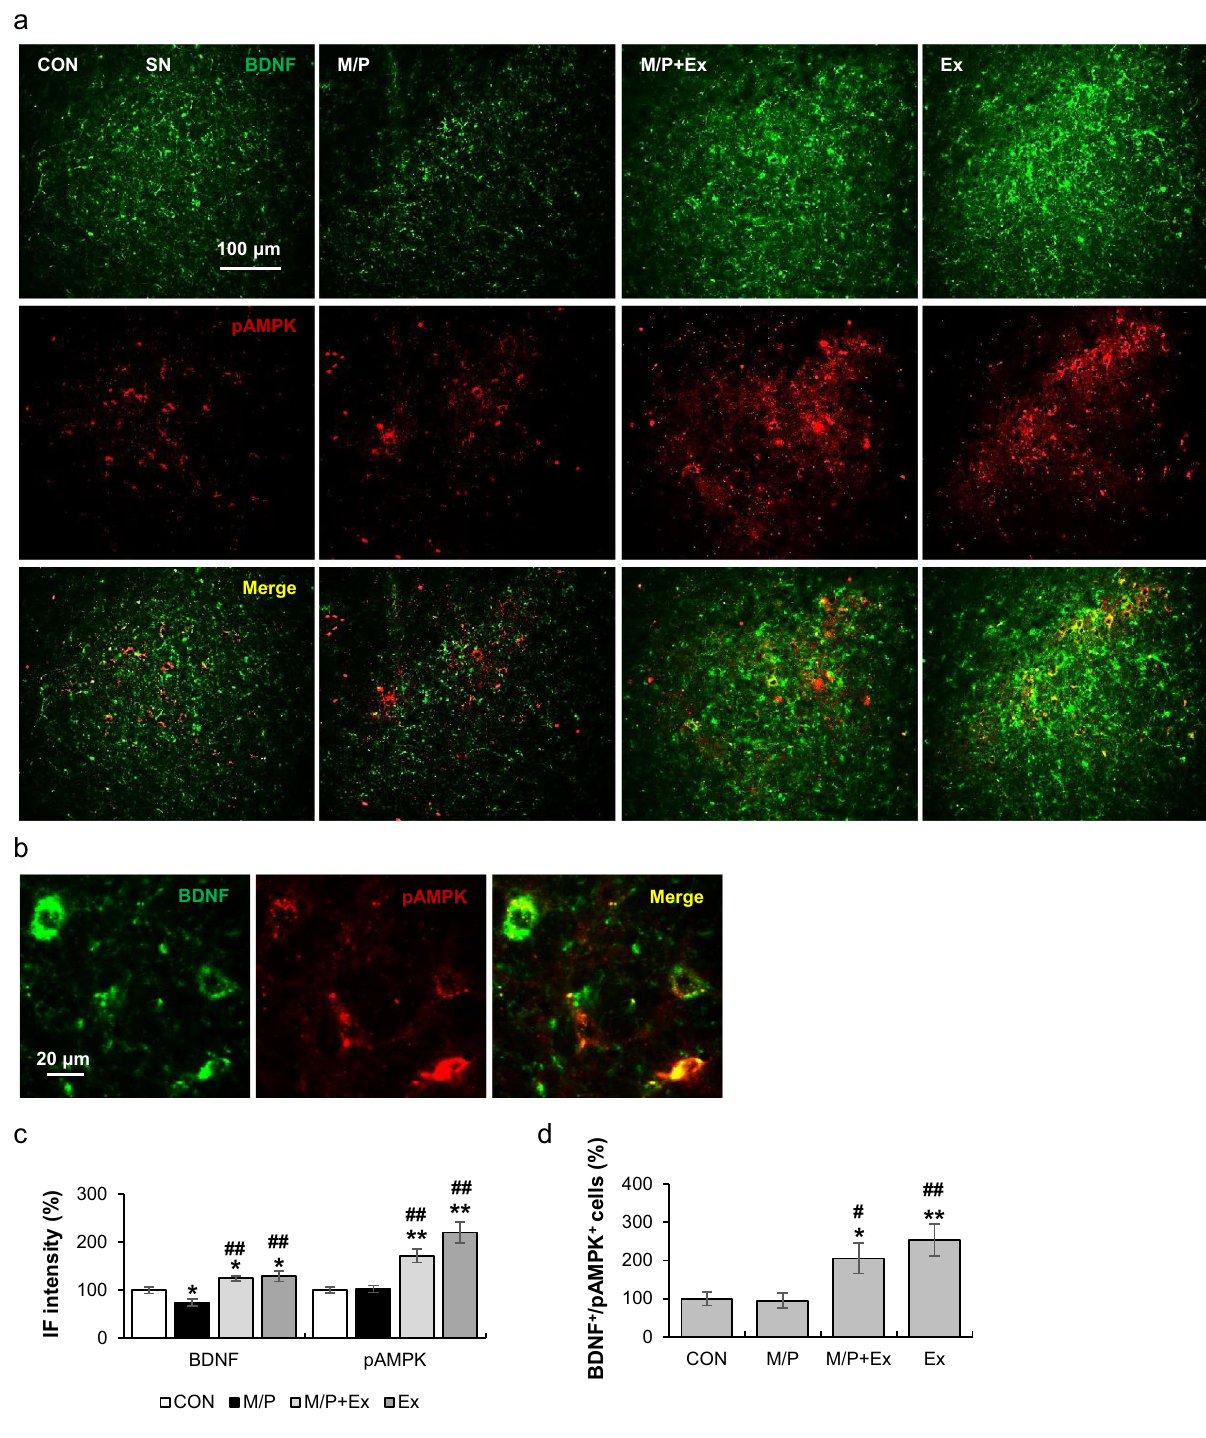
Figure 7. Rotarod walking exercise activated the AMPK/BDNF pathway in the SN area of M/P-treated mice. ( a ) Photomicrographs of the double fluorescent staining of SN BDNF + and pAMPK + cells (N = 8 in each group, 200 × of magnification). ( b ) Representative photomicrograph of the high magnitude of BDNF + /pAMPK + cells (400 × of magnification). ( c ) Quantification of the fluorescent intensity of SN BDNF + and pAMPK + cells showing that exercise restored the M/P-induced decrease in BDNF + cells, and enhanced the pAMPK + IF intensity, regardless of M/P treatment. ( d ) Quantification of the fluorescent staining of SN BDNF + /pAMPK + cells showing that exercise increased the number of BDNF + /pAMPK + cells, regardless of M/P treatment. Data are presented as mean ± SEM. *p < 0.05, vs. CON; **p < 0.01, vs. CON; # p < 0.05, vs. M/P; ## p < 0.01, vs.